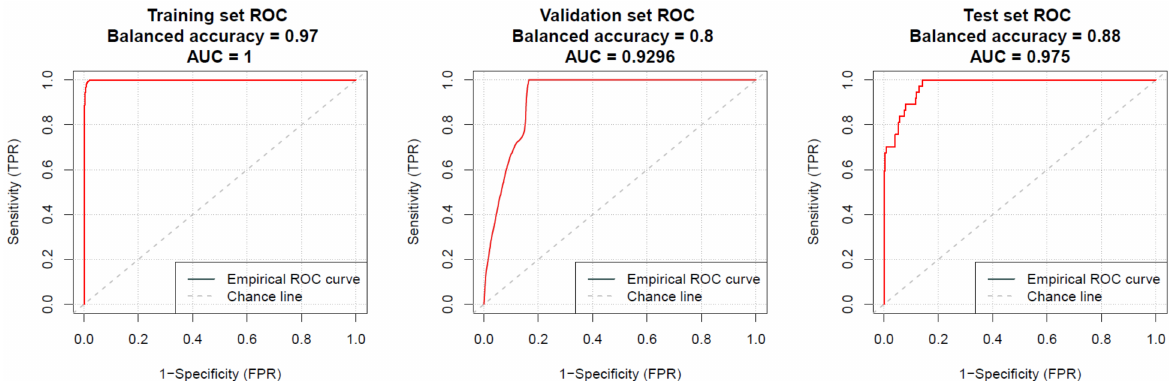
Figure 3. Receiver operating characteristic (ROC) curves representing the accuracy of imPlatelet classifier performance in the training, validation, and independent test set.